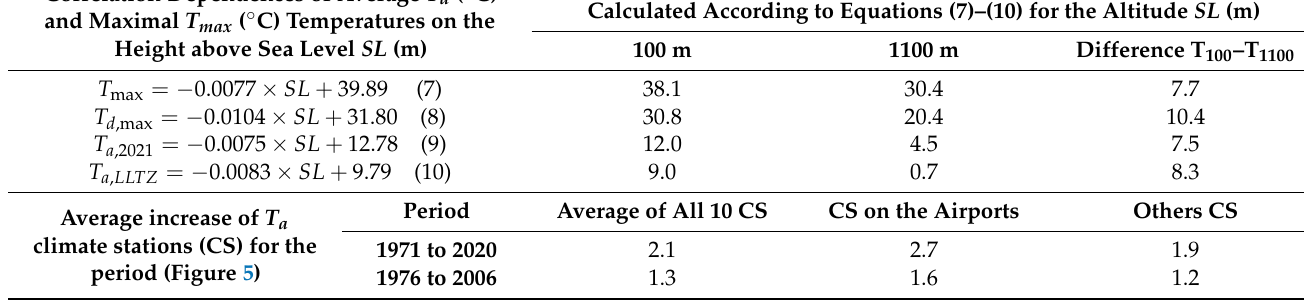
Table 5. Correlation dependences of average annual temperature T a ( ◦ C), average daily temperature T d ( ◦ C), and the maximum air temperature T max ( ◦ C) determined from the highest measured temper- atures in CS on the SL (m) of pavement and the average increase in T a climate stations (CS) between 2020 and